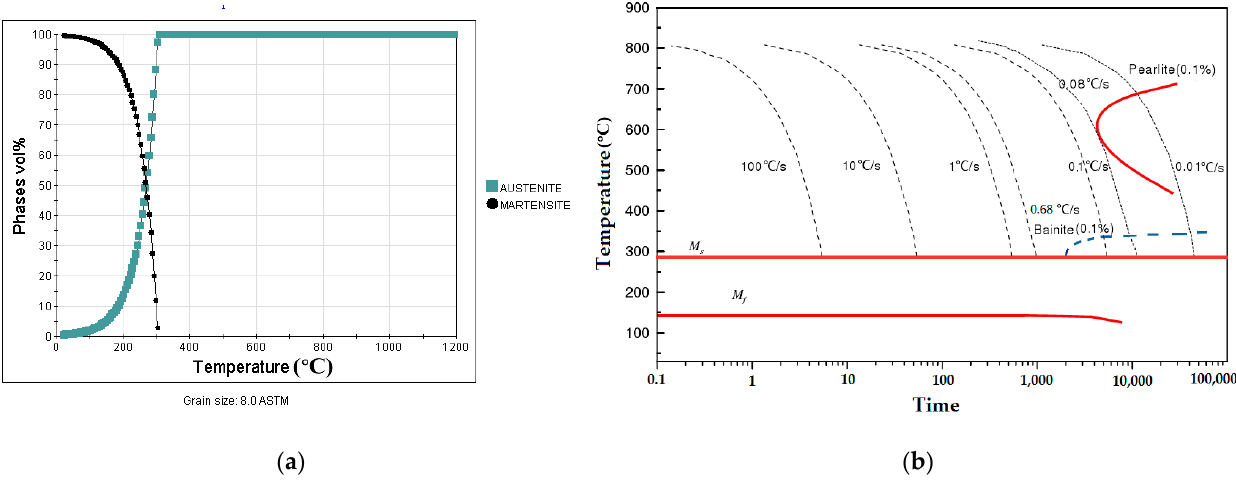
Figure 3. Calculated curves of X6CrNiMoVNb11-2 steel using the JMatPro database: ( a ) relationship between the phase composition and the cooling temperature at the cooling rate of 1 °C/s; ( b ) critical cooling rate curves.